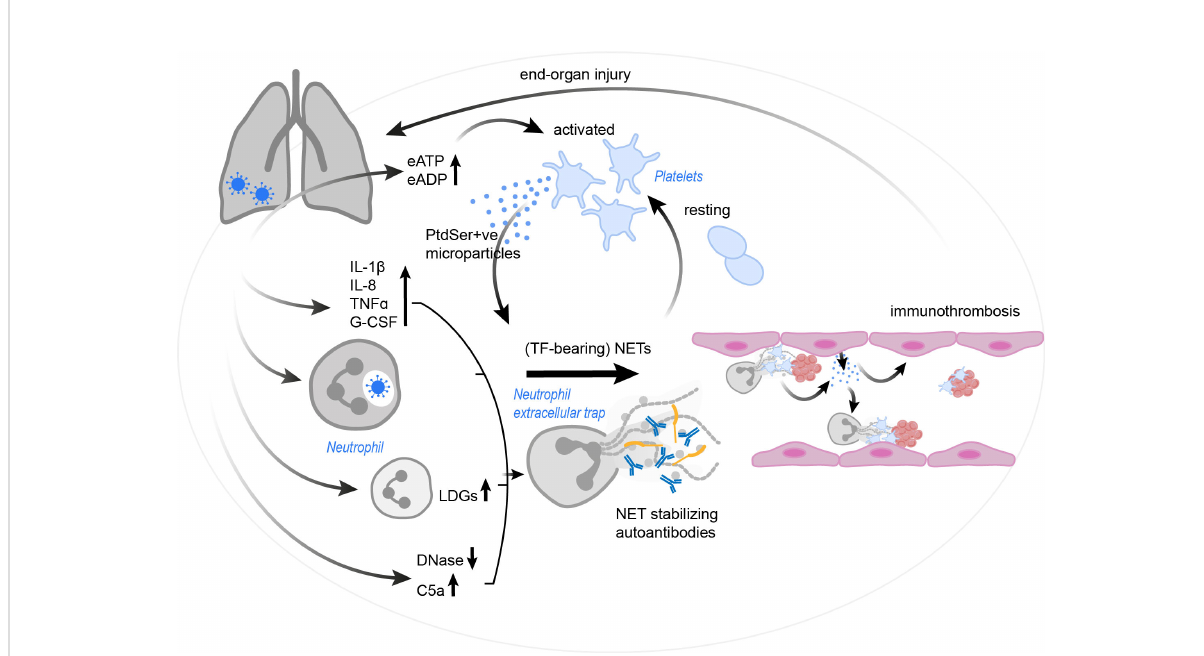
FIGURE 4 The vicious cycle of platelet-neutrophil interplay contributing to immunothrombosis in COVID-19. SARS-CoV-2 infection results in a drastic increase in pro-in fl ammatory cytokines and complement C5a, the occurrence of LDGs and a reduction in endogenous DNases. These effects, as well as the virus itself (via currently unknown mechanisms) may trigger and/ or enhance NET formation. Autoantibodies may further stabilize the formed NETs and protect them against removal. NETs in COVID-19 patients were found to have incorporated procoagulant tissue factor. Platelets are activated by the NETs, but also by an increase in eATP and eADP. Platelets might then react with the production of PtdSer+ve microparticles, which in turn may trigger NETosis and drive coagulation. Endothelial cells also release microparticles, stimulating neutrophils for NET formation. The resulting immunothrombosis very likely contributes to signi fi cant end-organ damage. C5a, complement C5a; COVID-19, corona virus disease 2019; DNase, deoxyribonuclease; eADP, extracellular adenosine diphosphate; eATP, extracellular adenosine triphosphate; G-CSF, granulocyte-colony stimulating factor; IL, interleukin; LDG, low density granulocyte; NET, neutrophil extracellular trap; PtdSer+ve, phosphatidylserine positive; TF, tissue factor; TNF a , tumor necrosis factor a ; SARS-CoV-2, severe acute respiratory syndrome